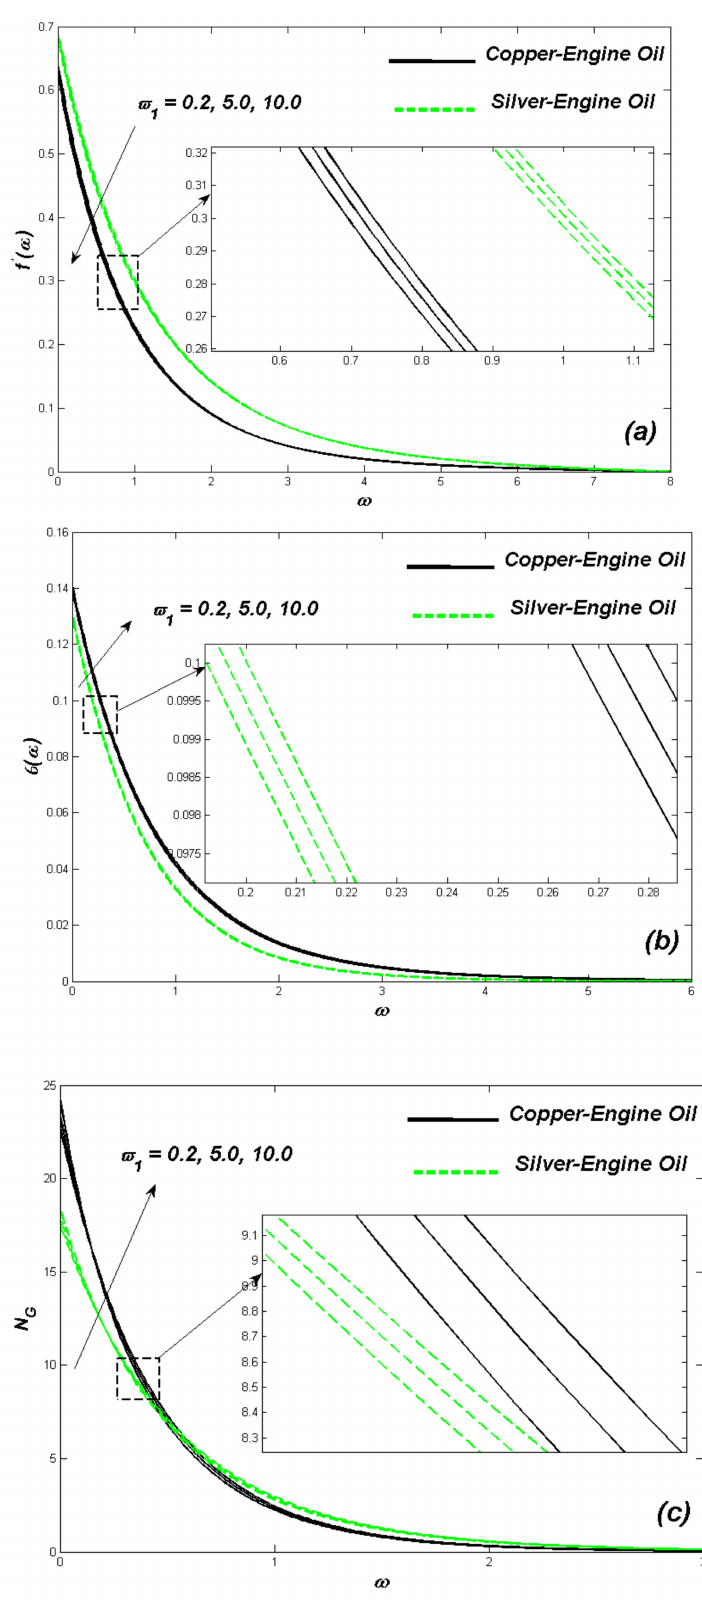
Figure 3. ( a ) Velocity change with (cid:118) 1 . ( b ) Temperature change with (cid:118) 1 . ( c ) Entropy change with (cid:118) 1